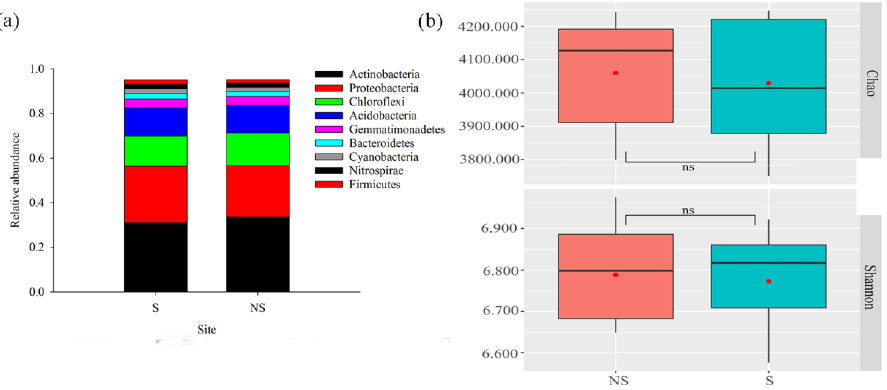
Figure 4. Relative abundances (average values >= 0.01) of dominant phylum composition ( a ) and alpha diversity of the soil bacterial community ( b ). * p < 0.05, ns, nonsignificant. Black dots indicate inter-group differences, and red dots indicate intra-group differences.